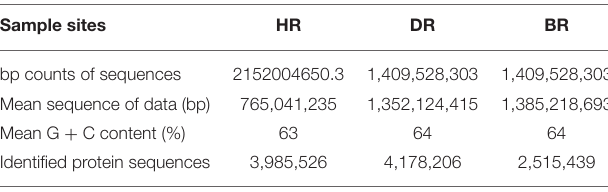
TABLE 1 | Analysis of sequenced data and diversity evaluation of the shotgun metagenomes of the tomato plant rhizosphere. Sample